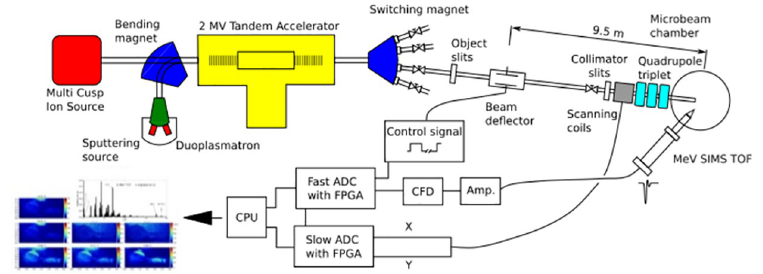
Fig 1. Schematic view of the MeV-SIMS setup at the JSI tandem